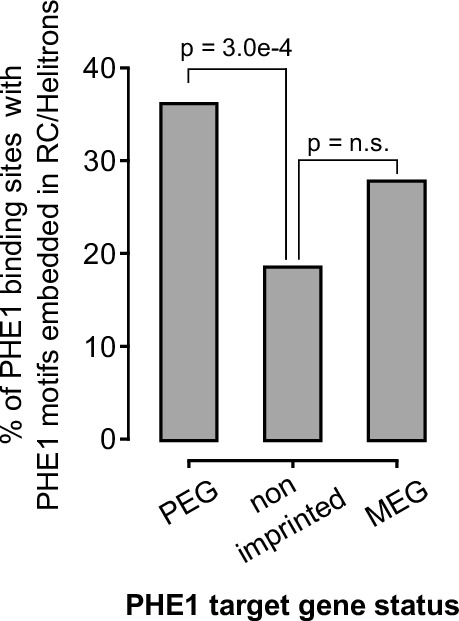
RC/Helitrons carrying PHE1 DNA-binding motifs are more prevalent in PEGs.Fraction of PHE1 binding sites targeting MEGs, PEGs, or non-imprinted genes where a spatial overlap between a RC/Helitron and a PHE1 DNA-binding motif is observed. P-values were determined using the hypergeometric test.